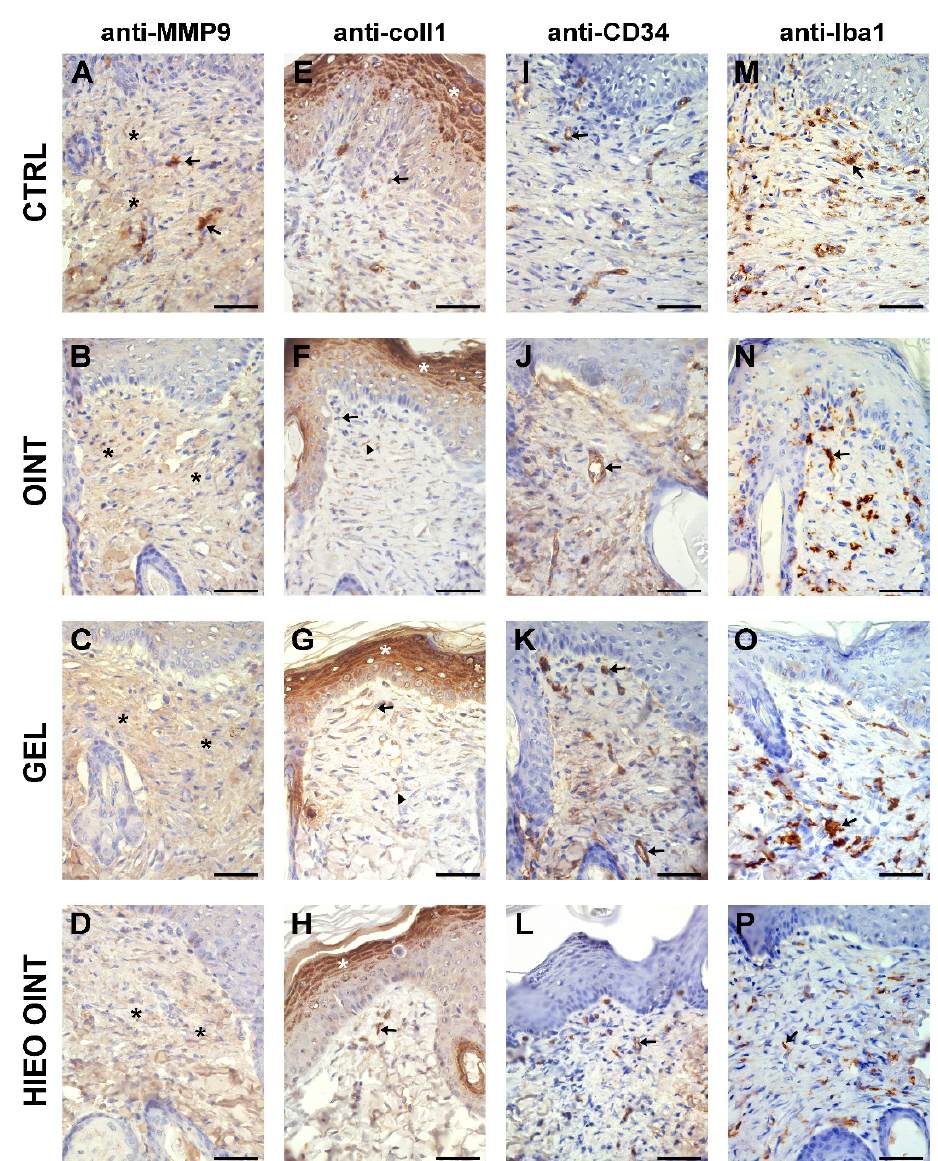
Figure 7. Representative immunohistochemical staining of MMP9, collagen I, CD34 and Iba1 in some animal groups. Scale bar, 50 µ m. Representative immunohistochemical staining of MMP9, collagen I, CD34 and Iba1 in CTRL group ( A , E , I , M ), OINT group ( B , F , J , N ), GEL group ( C , G , K , O ) and HIEO OINT group ( D , H , L , P ). Scale bar, 50 µ m. * indicate faint staining of the fibroblast cytoplasm in the dermis (black or white asterisk depending on the background); → indicate MMP9 ‐ positive cells in Figure 7A, collagen I ‐ positive fibroblasts in Figure 7E–H, CD34 ‐ positive capillary vessels in Figure 7I–L and Iba1 ‐ positive macrophages in Figure 7M–P; ▲ indicate fibers in Figure 7E–H.